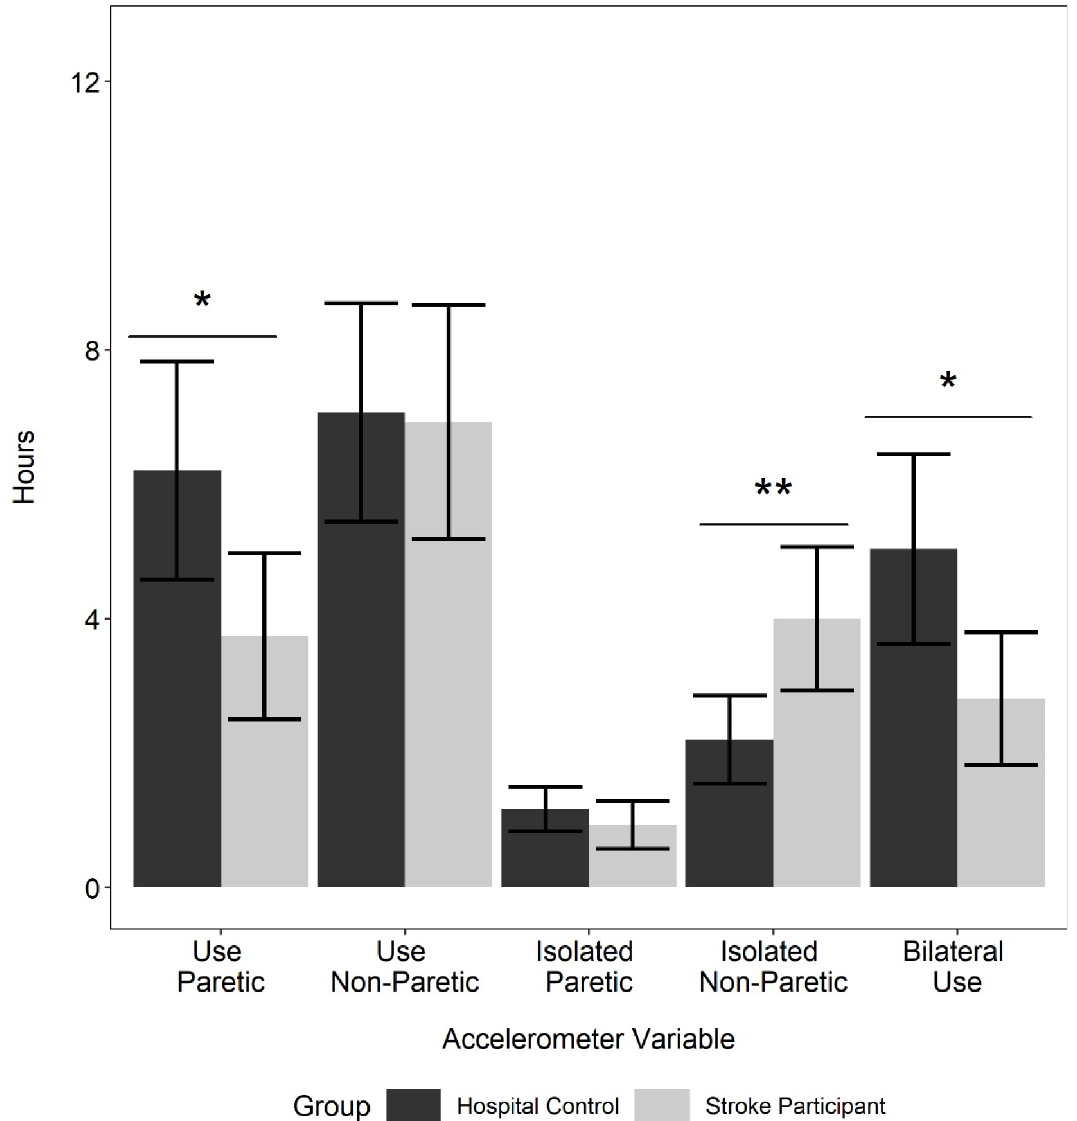
Fig 1. Quantification of UE movement using wrist-worn accelerometers. Stroke participants are compared to hospitalized controls. In Control participants (n = 12), the non-dominant limb was treated as the “paretic limb” and the dominant limb was treated as the non-paretic limb in those with stroke. Persons with stroke (n = 25) show a shift to unimanual use of the less affected side when compared to hospitalized controls, and significantly decrease their bilateral movements compared to hospitalized controls.